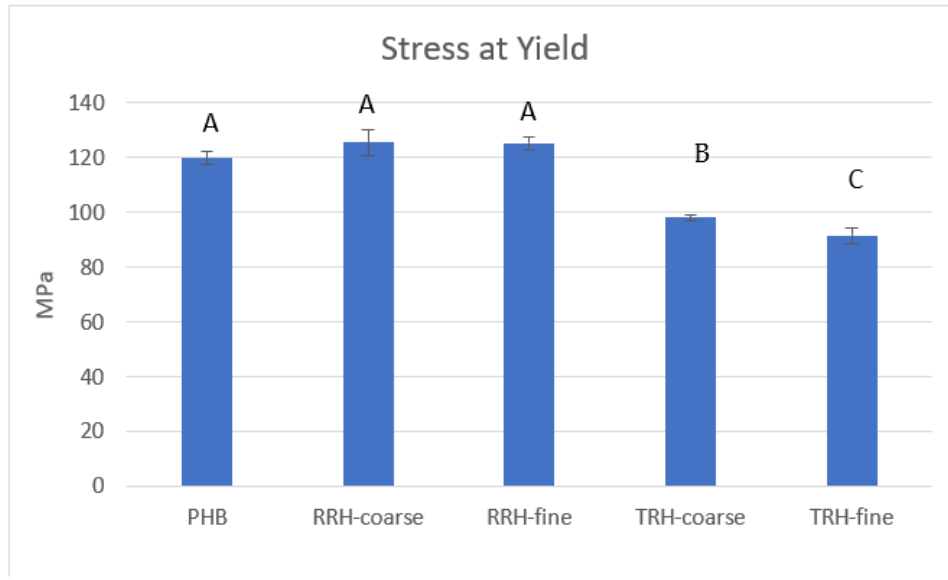
Figure 9. Stress at yield measured for PHB, PHB with 10% coarse RRH, PHB with 10% fine RRH, PHB with 10% coarse TRH, and PHB with 10% fine TRH composite samples. Means with the same letter in each category are not significantly different by Tukey’s test ( α = 0.05).